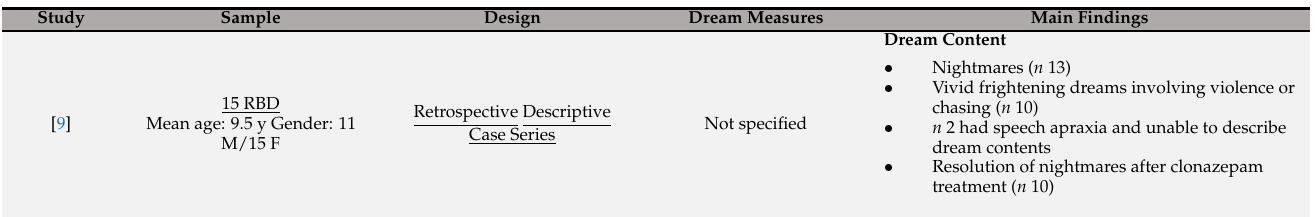
Table 4. Sample, design, tools, and findings in the study investigating dreaming in children with